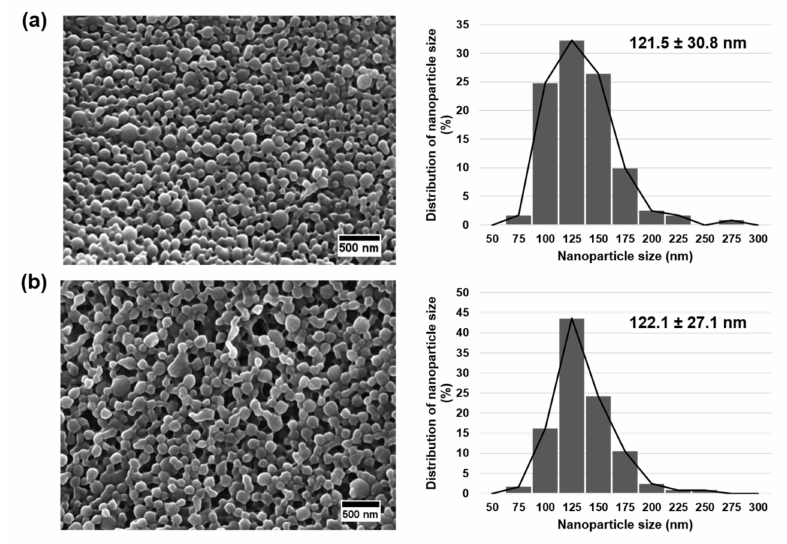
Figure 2. Morphology and distribution of NPs via FE-SEM. ( a ) Control NPs and ( b ) conjugated NPs examined by FE-SEM. Scale bar represents 500 nm.